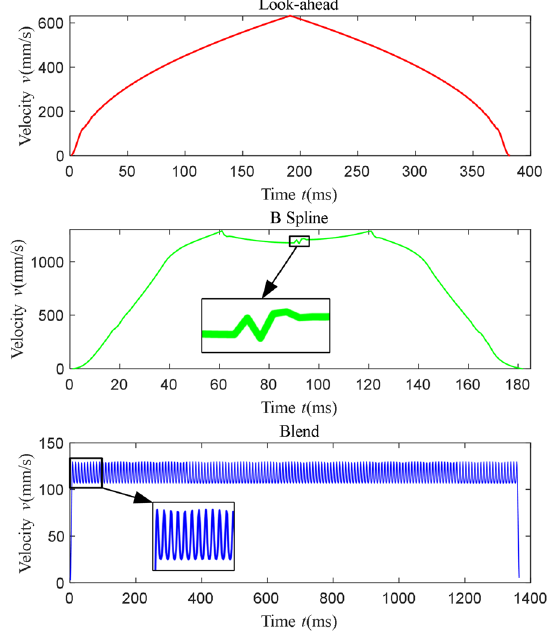
Figure 6 Comparison of velocity values for the three methods